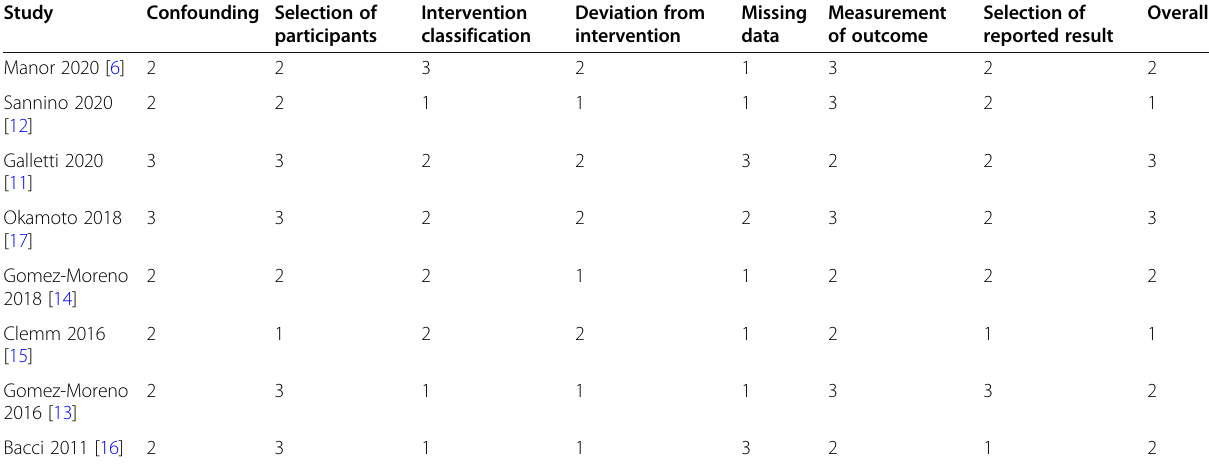
Table 2 ROBINS-I tool risk of bias in non-randomised studies Study Confounding Selection of